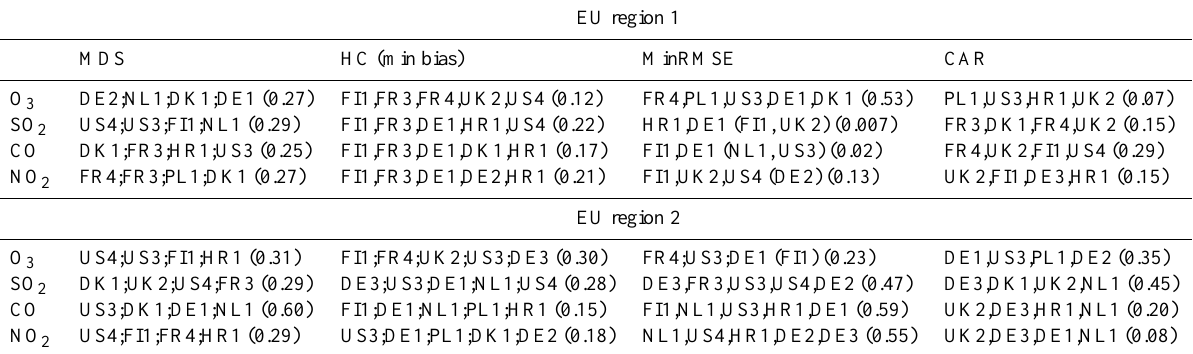
Table 4. Representative models (corr( d i , d j ) for the months of JJA). The number in parenthesis is the redundancy index ρI for each